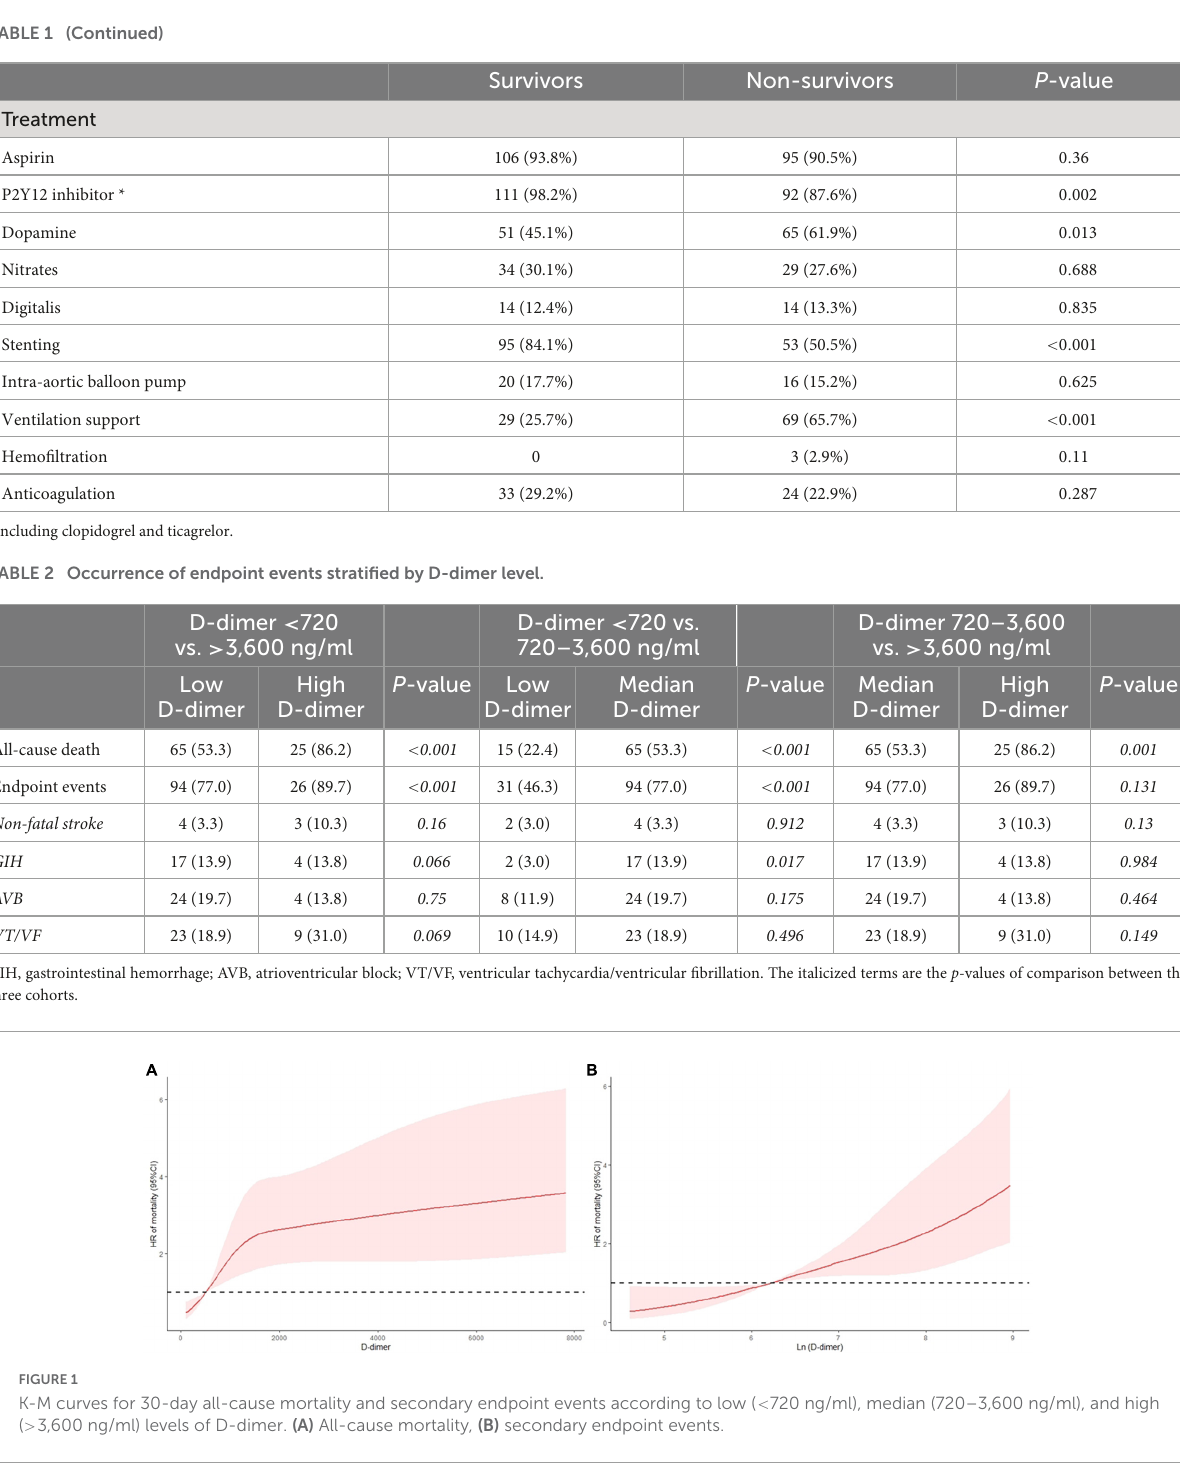
Using the risk prediction models combined with established risk factors and stratified D-dimer level, we calculated the